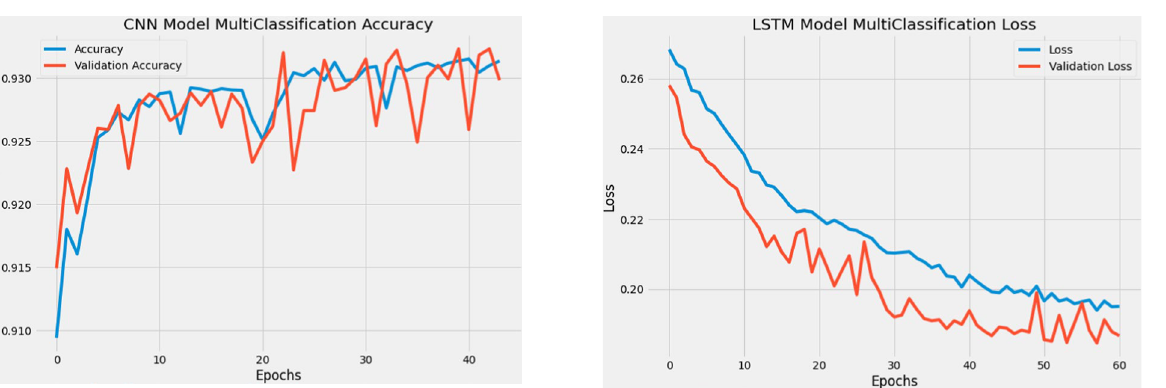
Fig. 16 Training and validation loss of LSTM